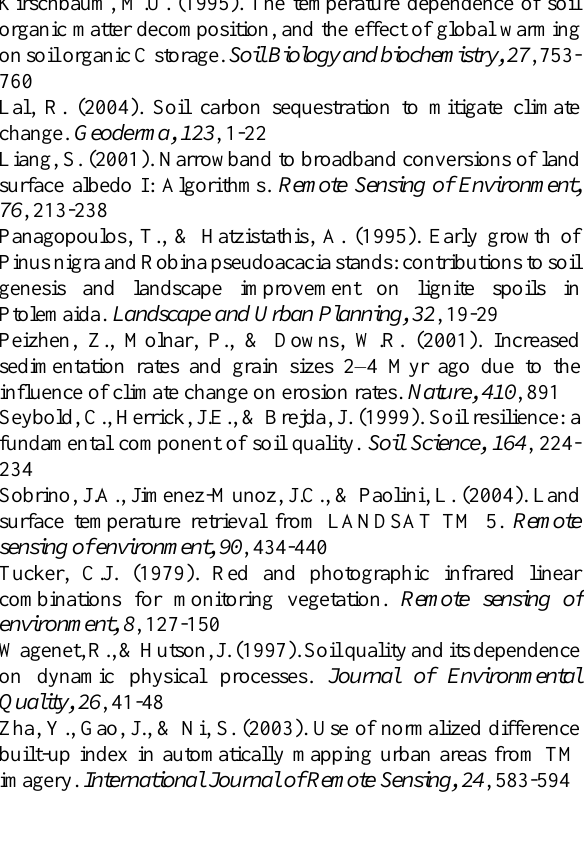
Figure 5. The surface biophysical characteristics maps of the the pixels with soil cover in 1987, 2000, and